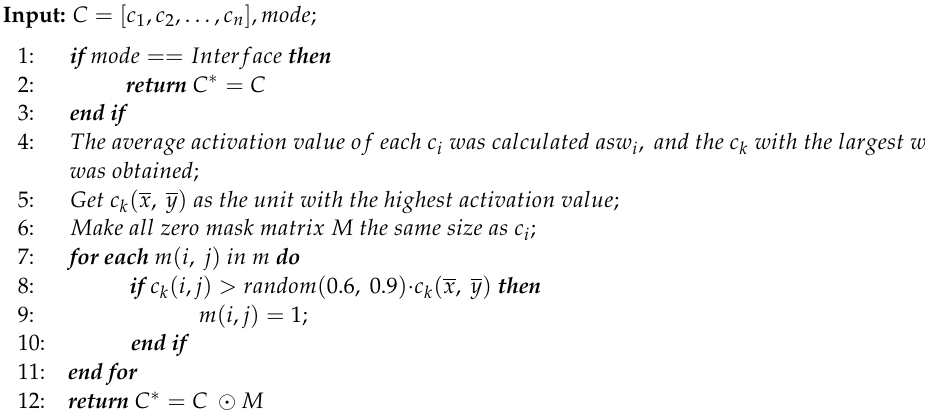
Algorithm 1: Mask Generation Based on